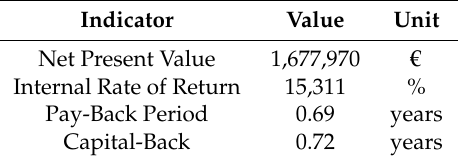
Table 5. Results of main financial indicators (5 years of lifespan, 5.5% discount